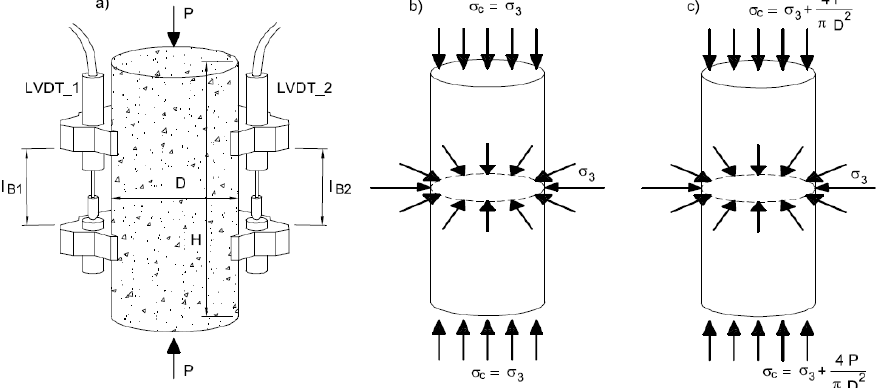
Figure 5: The two stages of triaxial tests on cement-based cylinders.